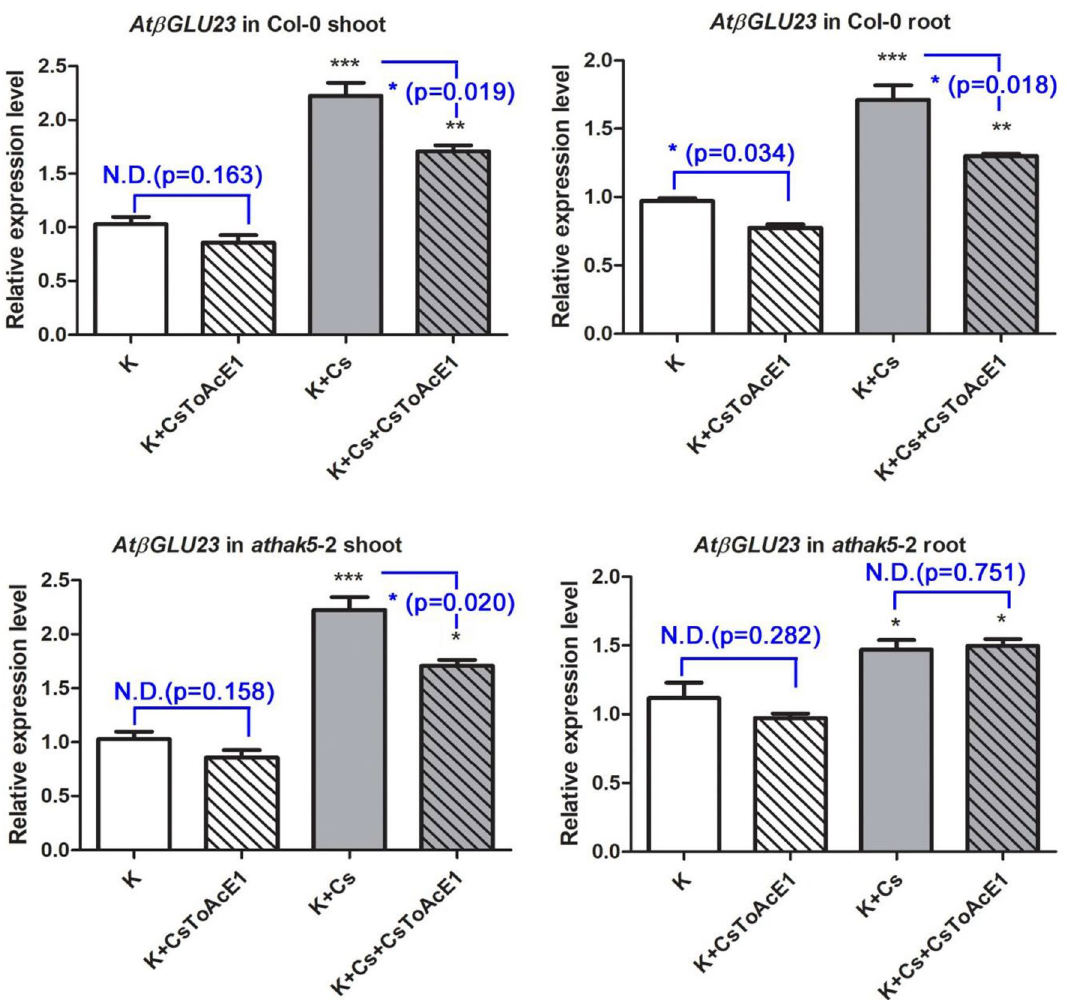
Figure 4. Analysis of AtβGLU23 expression. The relative expression of AtβGLU23 determined in 8-day-old Col-0 and athak5 -2 shoot and root samples, in response to 25 µM CsToAcE1, Cs, or a combination of Cs and CsToAcE1. Error bars indicate standard errors (n = 3). Statistical differences relative to a control (K) were determined using a Tukey’s comparisons test and statistical differences between no CsToAcE1 treated and CsToAcE1 treated were determined using student t-tests (N.D., no difference; * p < 0.05; ** p < 0.01; *** p <